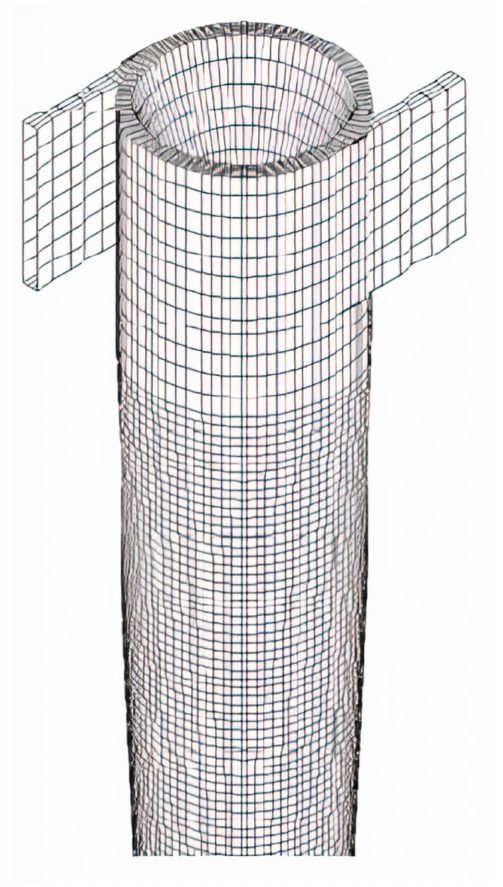
Figure 3. Details of the numerical mesh M1 used in the